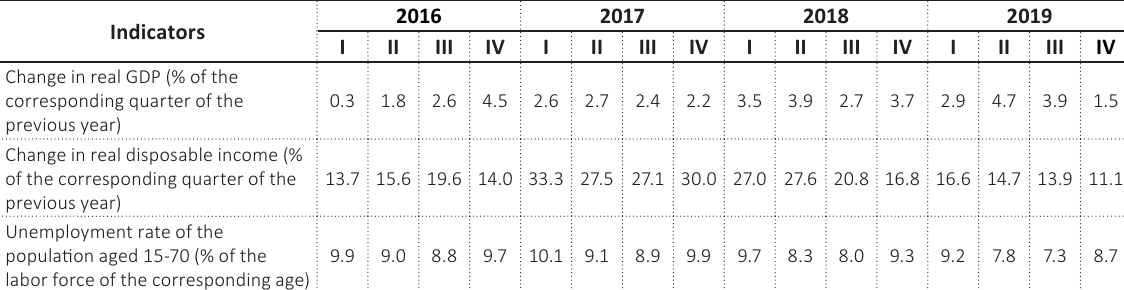
Table 2. Quarterly dynamics of individual macroeconomic indicators in Ukraine in